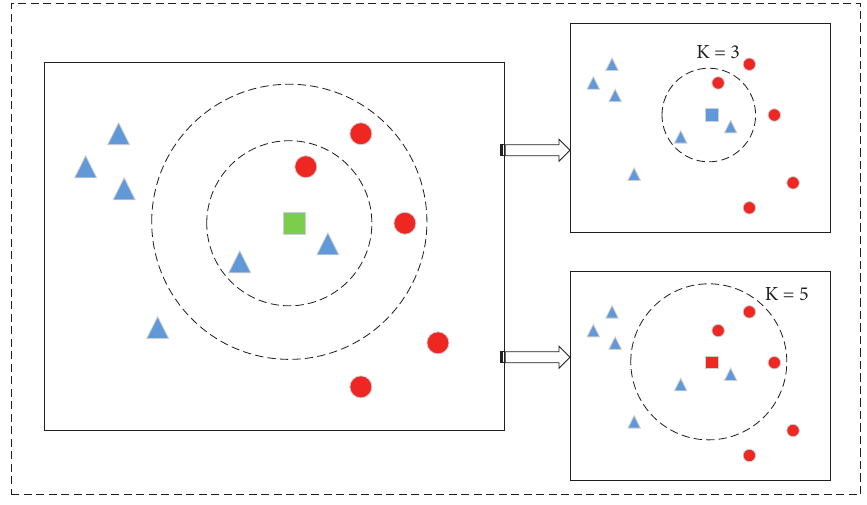
Figure 5: Schematic diagram of the KNN algorithm.